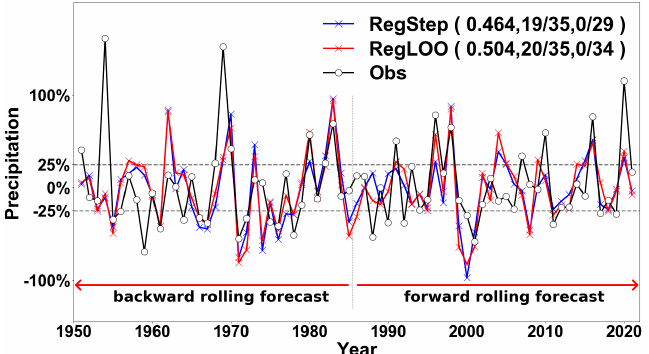
Figure 3. The precipitation anomaly percentage (%) from observations (Obs, black line) and rolling forecast experiments with the RegStep (blue line) and RegLOO (red line) approaches. The dashed lines indicate the precipitation thresholds for abnormal years. Forecast skills (Cor, Succ, and Bad) are shown after the corresponding experiment names.